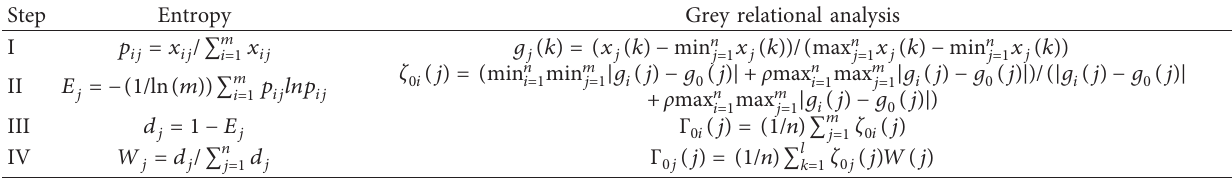
Table 2: Steps of entropy and grey relational analysis.